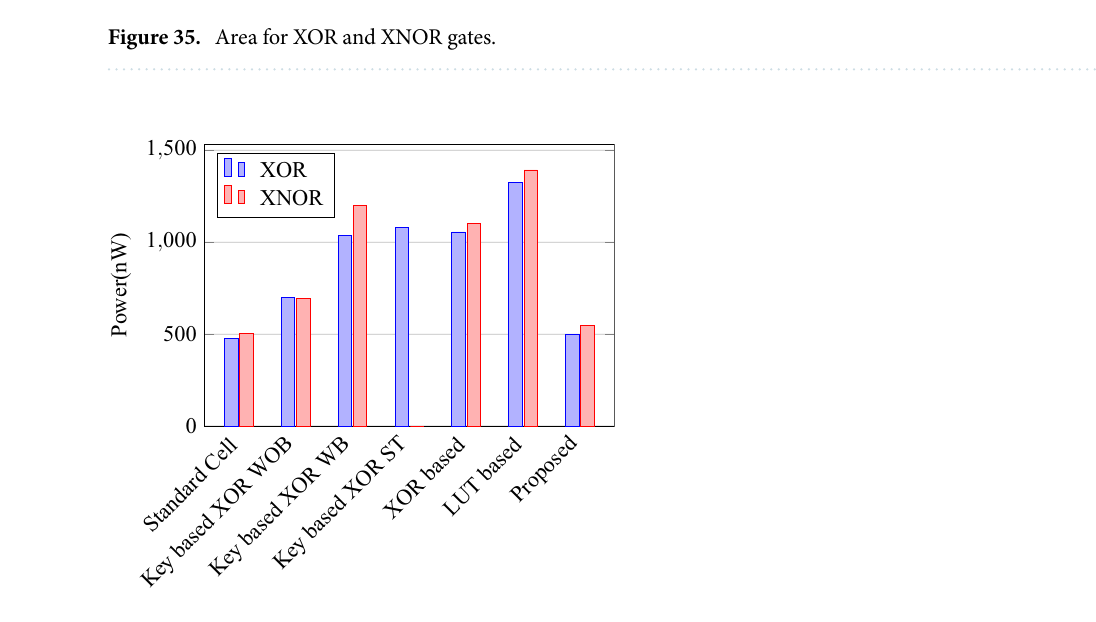
Figure 36. Power for XOR and XNOR